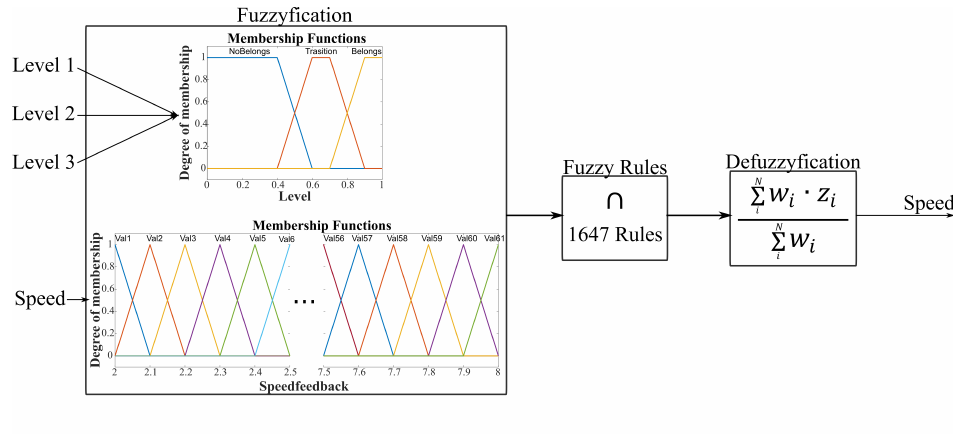
Figure 3. Assistance modulation based on a Sugeno-fuzzy MISO model. Three inputs are from the ANN classifiers corresponding to the muscular level condition, and the other input is the velocity feedback. The output is the velocity reference of the active tracking-motion